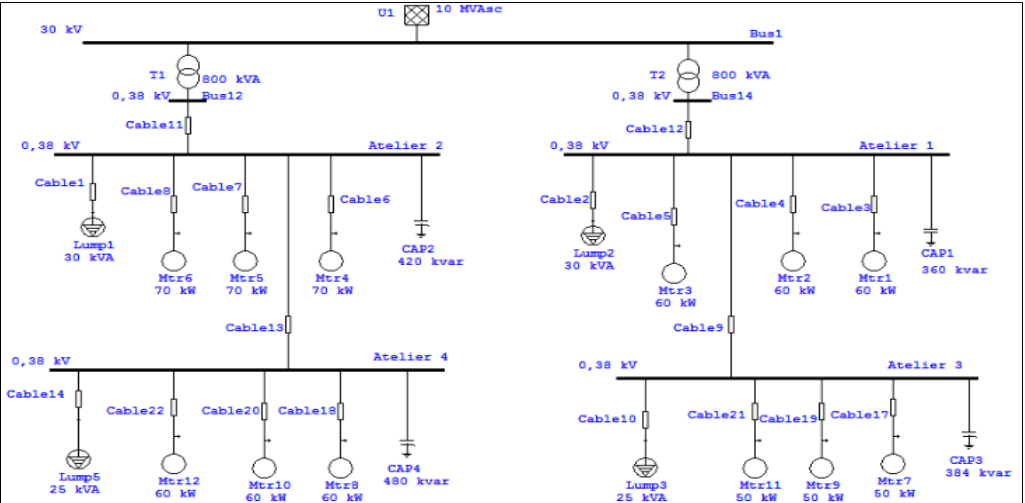
Figure 5: The Insertion of capacitor banks in the